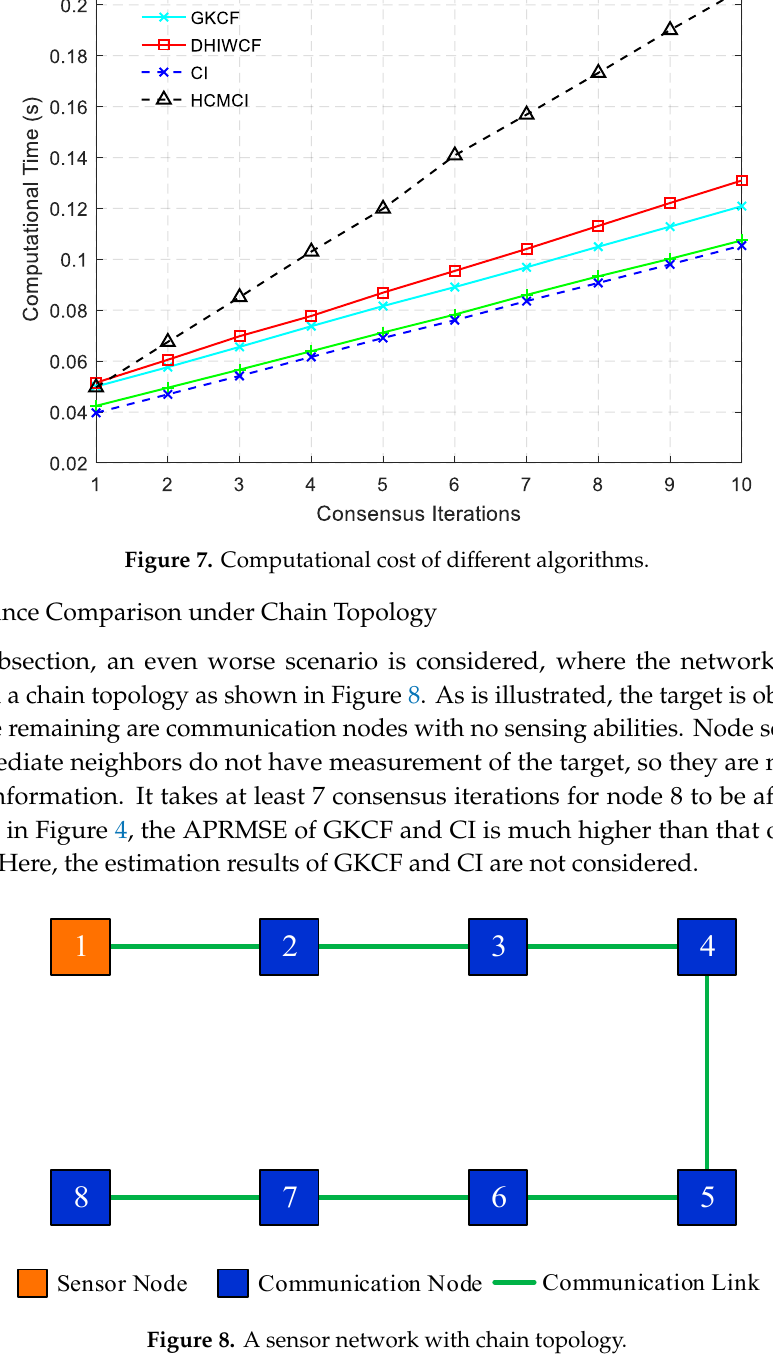
Figure 8. A sensor network with chain topology.